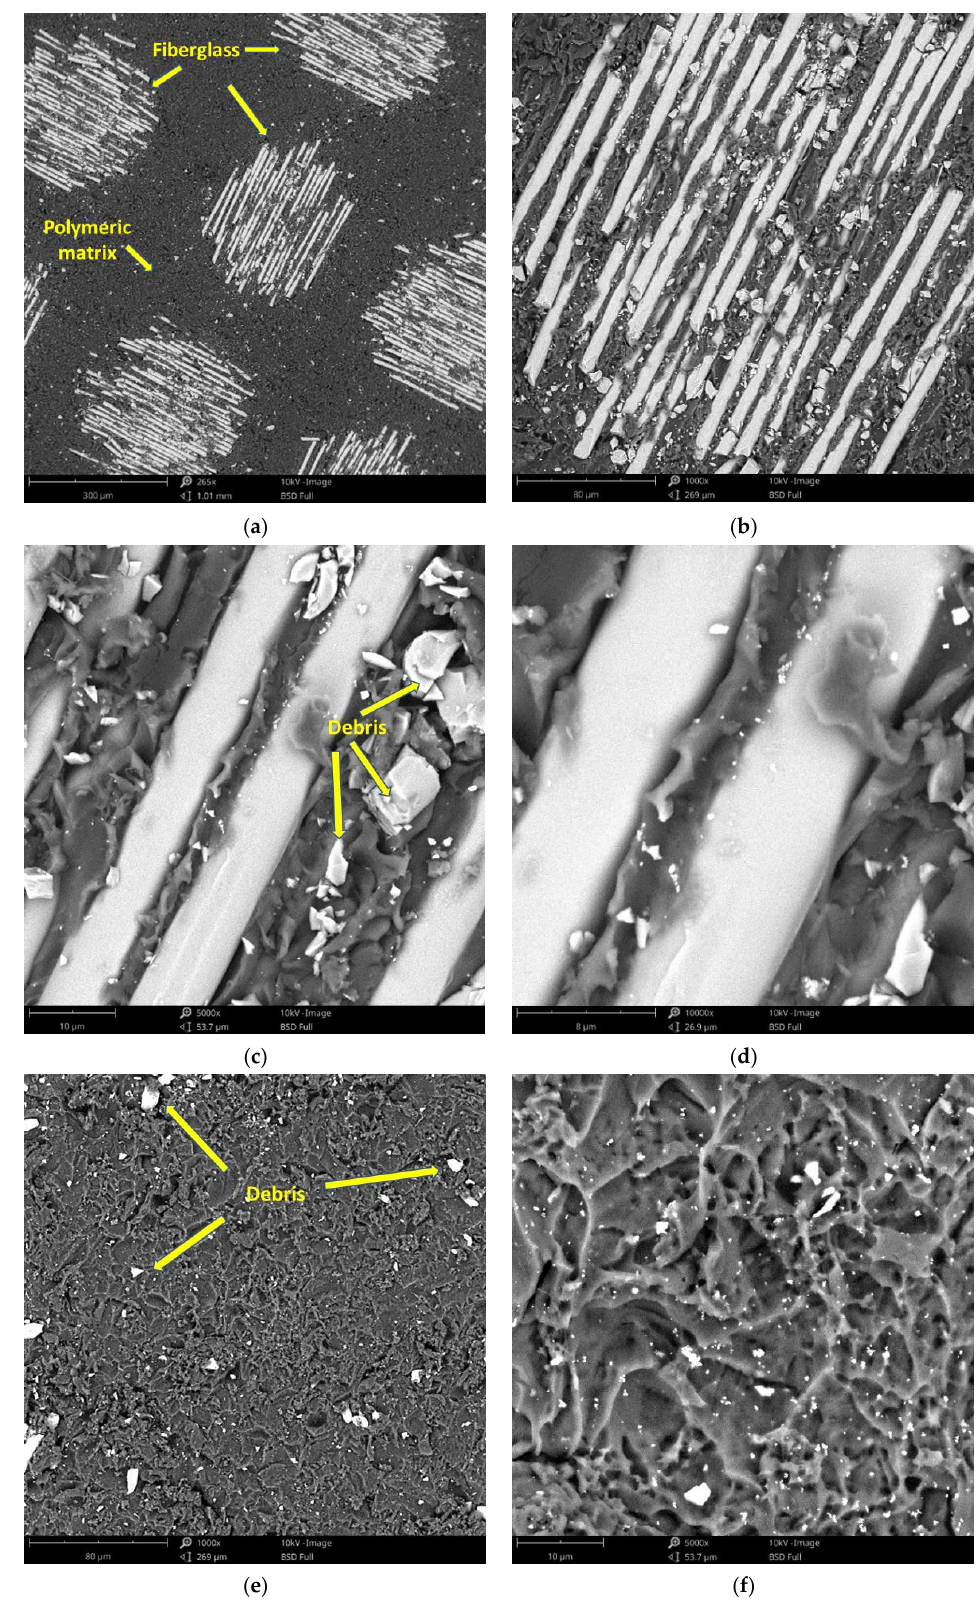
Figure 2. SEM images of sample C1 surfaces: ( a ) fiberglass at 265×; ( b ) fiberglass at 1000×; ( c ) fiberglass at 5000×; ( d ) fiberglass at 10,000×; ( e ) polymer matrix at 1000×; ( f ) polymer matrix at 5000×.